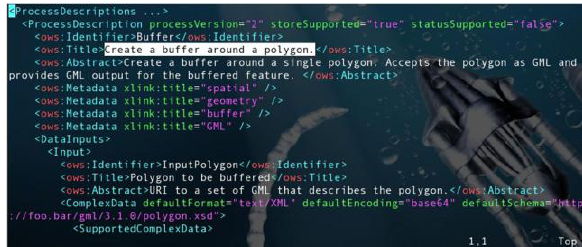
Figure 13. Sample WPS process